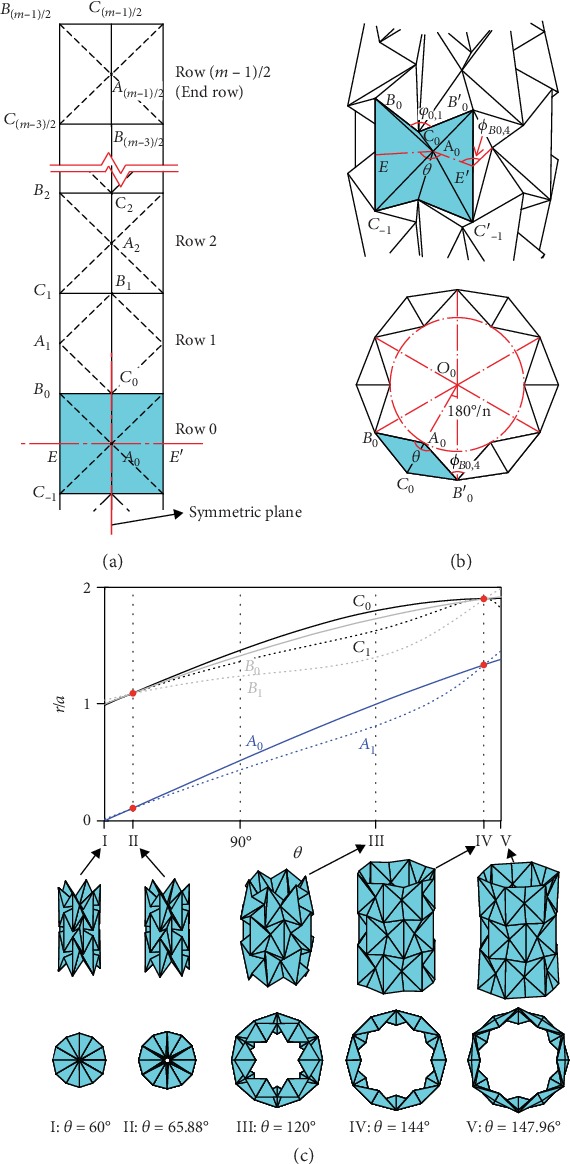
Rigid foldability of the waterbomb tube with an odd m. (a) Top half of a longitudinal strip in a waterbomb tube. E‐E′ is the equator of the tube. Vertices above the equator are marked as Ai, Bi, and Ci, while those below are marked as A‐i, B‐i, and C‐i, in which 0 ≤ i ≤ (m‐1)/2. (b) The front view of a waterbomb tube with the equatorial row 0 and rows immediately adjacent to it and the top view of the equatorial row. One of the bases on the equatorial row is shown in blue. O0 is the center of the tube. (c) Variation of nondimensional radii r/a of vertices Ai, Bi, and Ci (i = 0, 1) of a tube with m = 3, n = 6, and α = 45° with respect to the folding angle θ and five representative configurations I to V of the tube in front and top views. The corresponding angles θ are listed below the configurations. Also see SM Movie S1.